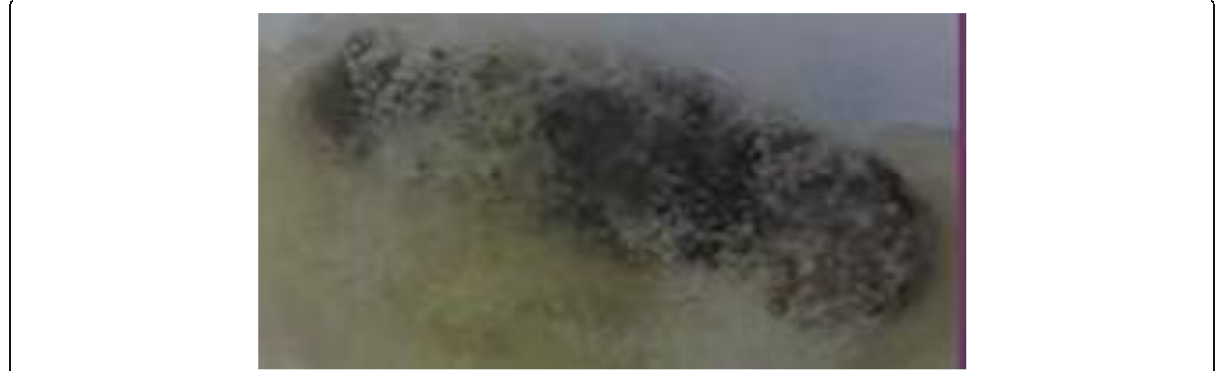
Fig. 3 Fungal hyphae emerged from the cadaver of Spodoptera littoralis larvae treated with spore suspension of Curvularia lunata by dipping